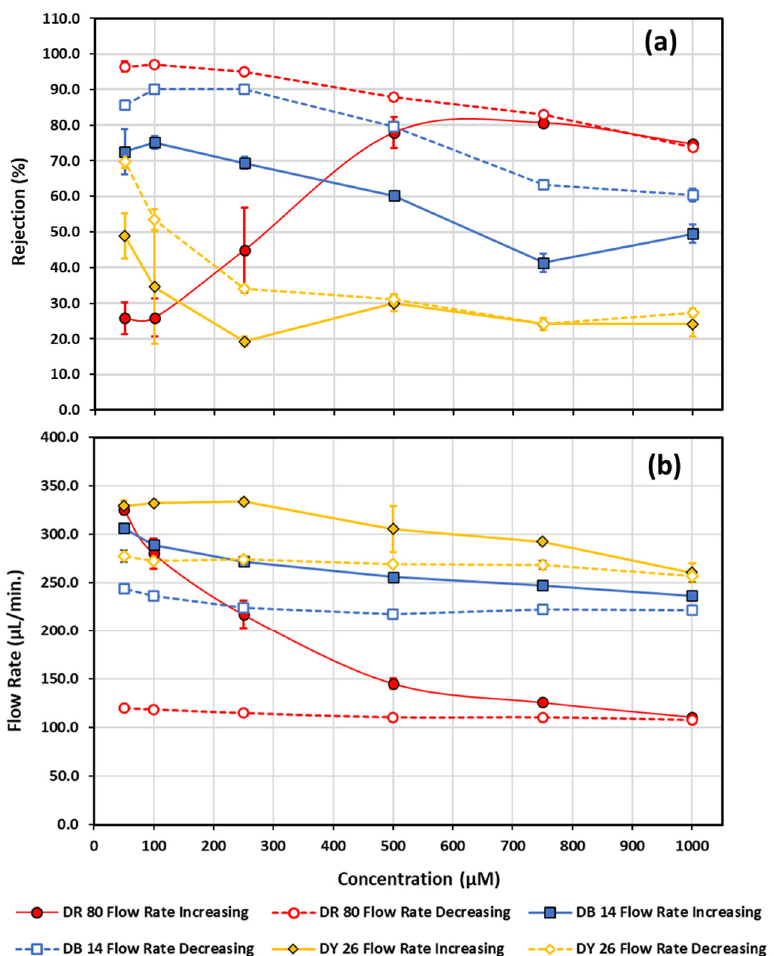
Figure 8. Rejection ( a ) and flow rate ( b ) measurements as a function of increasing and decreasing concentration are shown for direct red 80, direct blue 14, and direct yellow 26. Solid data points connected by a solid line correspond to measurements made going from low to higher concentration, while open data points connected by a dashed line correspond to measurements made while going from high to lower concentration. Diamonds—direct yellow 26; squares—direct blue 14; circles—direct red 80.